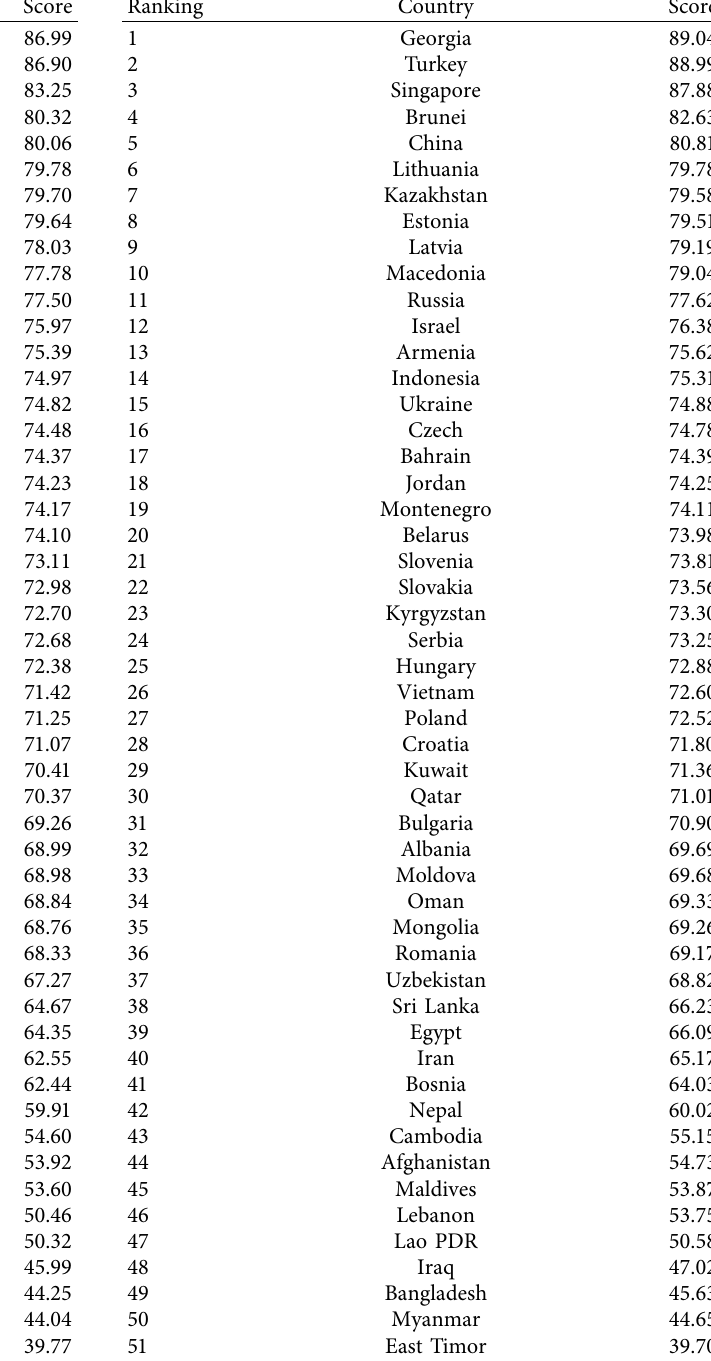
Table 7: Predicted score and ranking for 2022. Table 6: Predicted score and ranking for